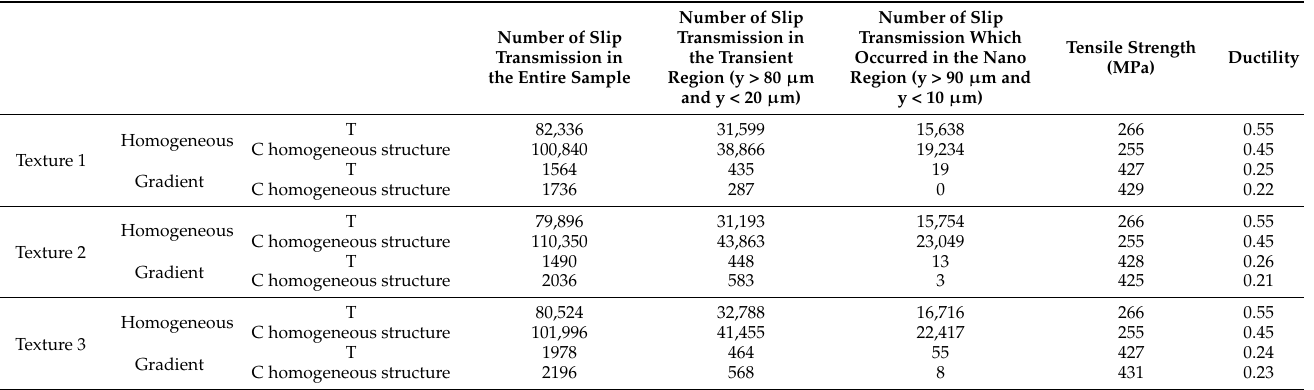
Table 3. Number of slips per region, tensile strength, and ductility in specimens with homogeneous and gradient structures, under tension and compression, for three initial textures. Results are recorded at 20 %